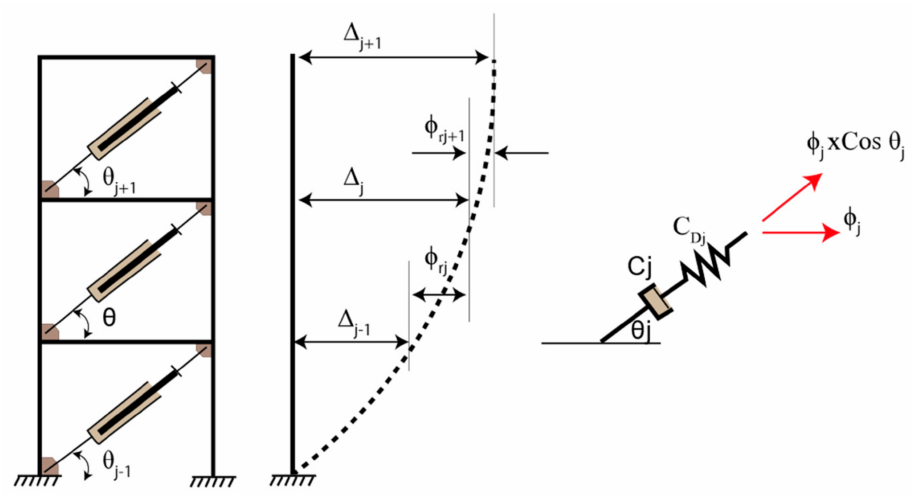
Figure 5. Multi degree of freedom (MDOF) with oil dampers corresponding to the first mode of vibration.